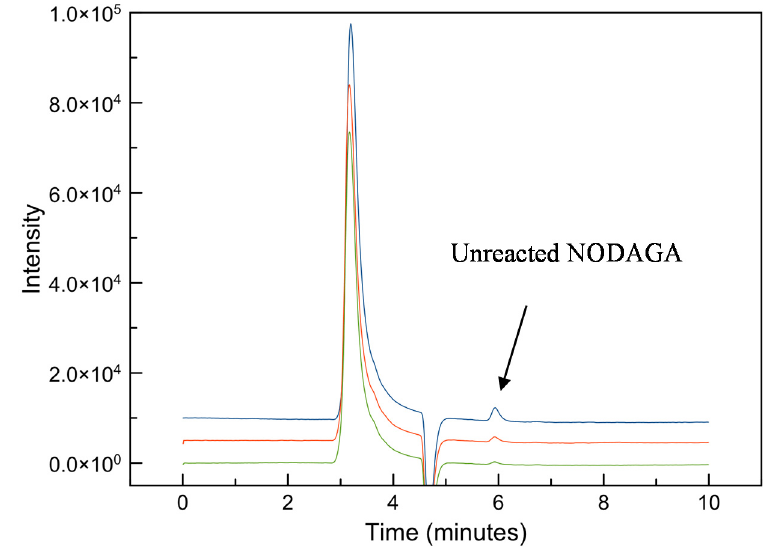
Figure 8. The re-analysis of the collected NODPAM precursor shows a considerable amount of Figure 8. The re ‐ analysis of the collected NODPAM precursor shows a considerable amount of unreacted NODAGA unreacted NODAGA chelator.